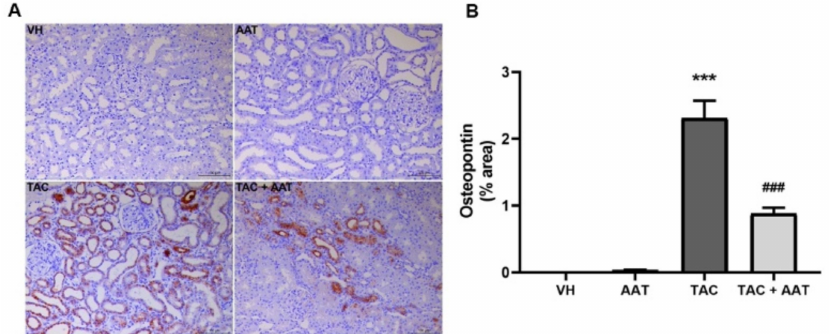
Figure 4. E ff ect of alpha-1 antitrypsin on osteopontin staining in tacrolimus-induced renal injury. ( A ) Immunohistochemical staining for osteopontin (200 × magnification). ( B ) Quantitative analysis of osteopontin staining area. Data are presented as means ± standard errors; *** p < 0.001 vs. VH; ### p < 0.001 vs. TAC. Abbreviations: VH, vehicle group; AAT, alpha-1 antitrypsin treatment group; TAC, tacrolimus treatment group; TAC + AAT, tacrolimus and alpha-1 antitrypsin cotreatment group.